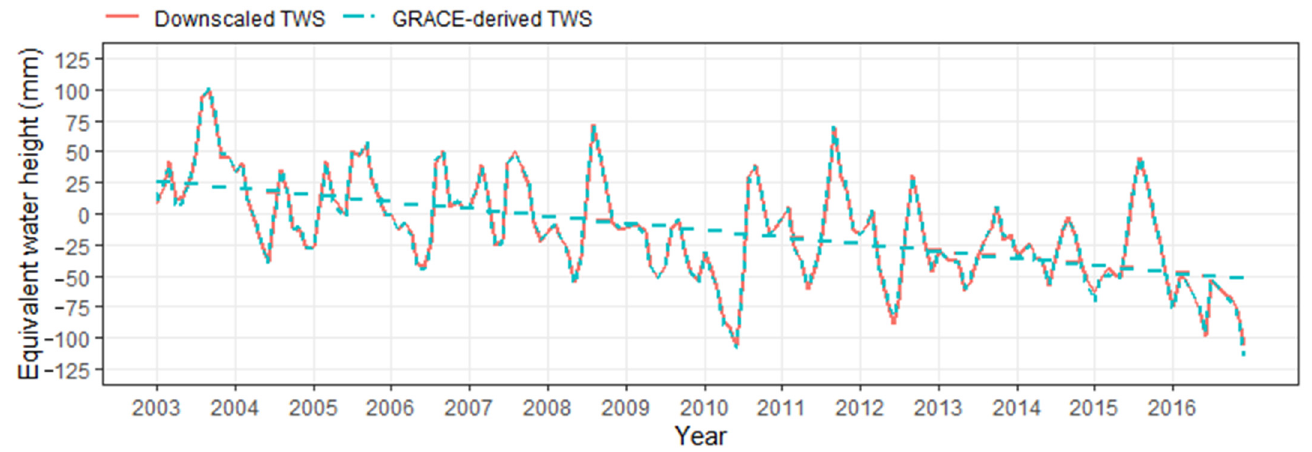
Figure 9. Terrestrial water storage (TWS) time series before and after downscaling in IBIS.